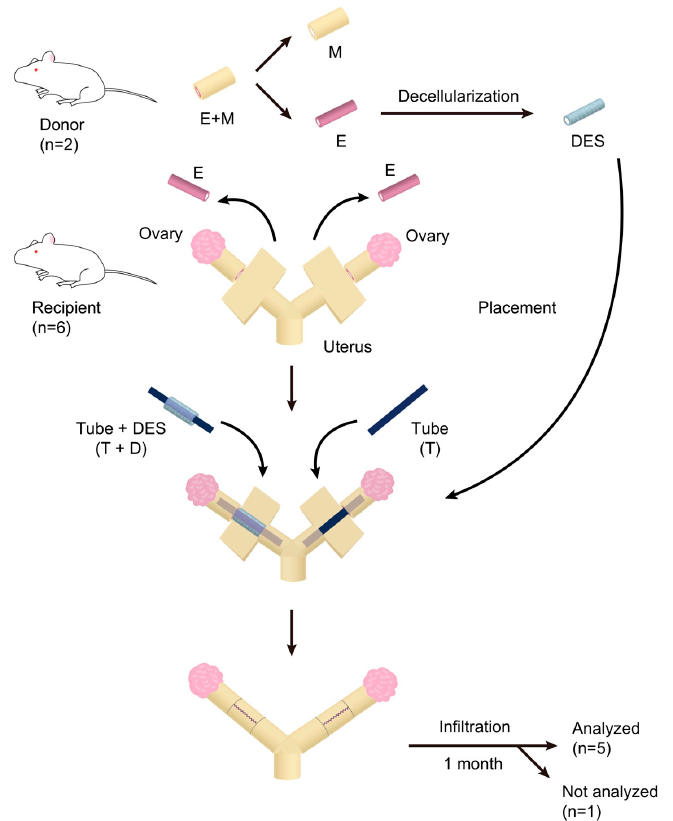
Figure 6. Overview of experimental design and procedures. The uterus of a donor rat was excised, and the endometrium (E) was separated from the outer layer, which consists mainly of myometrium (M), of the uterus. The separated E was decellularized and designated as a decellularized endometrium scaffold (DES). The recipient rat underwent the same separation of E but without excision of the uterus, such that a 1.5 cm long section of E alone was removed and the M of both uterine horns remained. A silicone tube or a tube-loaded DES was placed into the endometrium-deficient section of each uterine horn, and the outer muscle layer was then closed with continuous suturing. The silicone tube was used to prevent intrauterine adhesion. A month later the uterus was excised for histological and immunofluorescence microscopic analyses. The number of rats used as indicated are shown in parentheses.